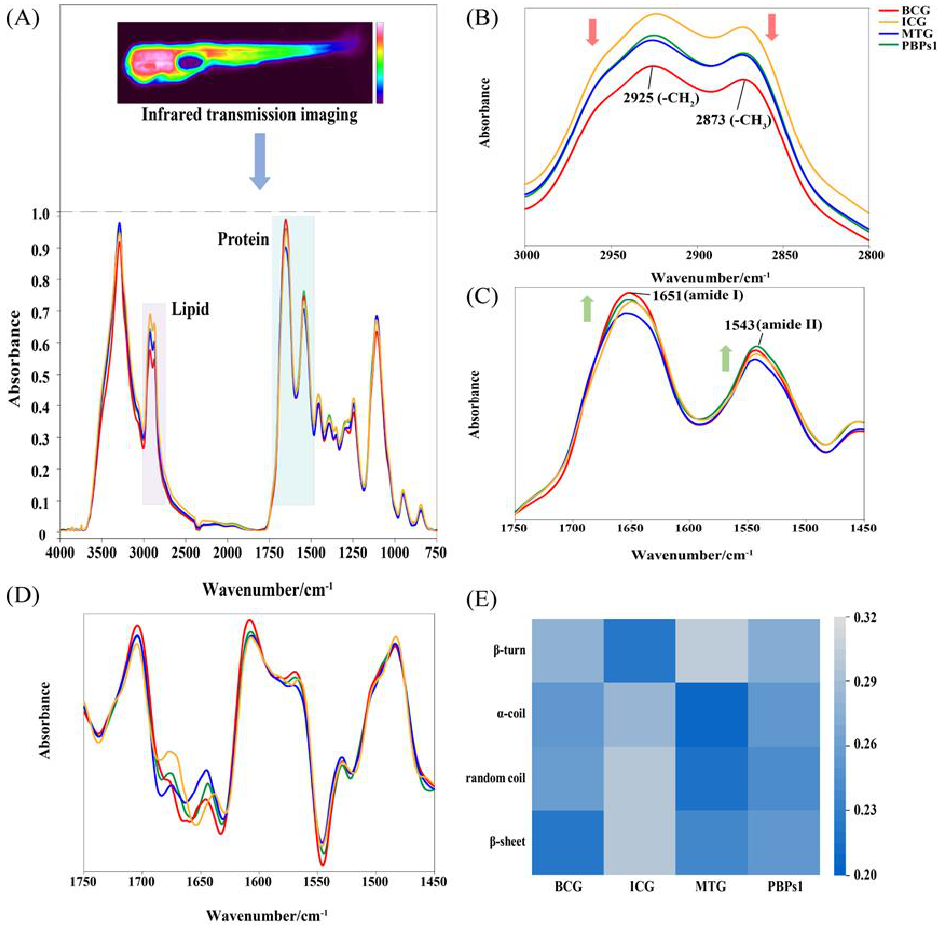
Figure 2. IR spectra of zebrafish at 4000 – 750 cm −1 ( A ); IR spectra of zebrafish at 3000 – 2800 cm −1 ( B ); IR spectra of zebrafish at 1750 – 1450 cm −1 ( C ); SD-IR spectra of zebrafish at 1750 – 1450 cm −1 ( D ); heat map of protein secondary structure occupancy ( E ). Blank control group (BCG), normal growth of zebrafish without adding any drugs; Insomnia control group (ICG); Positive drug (melatonin) group